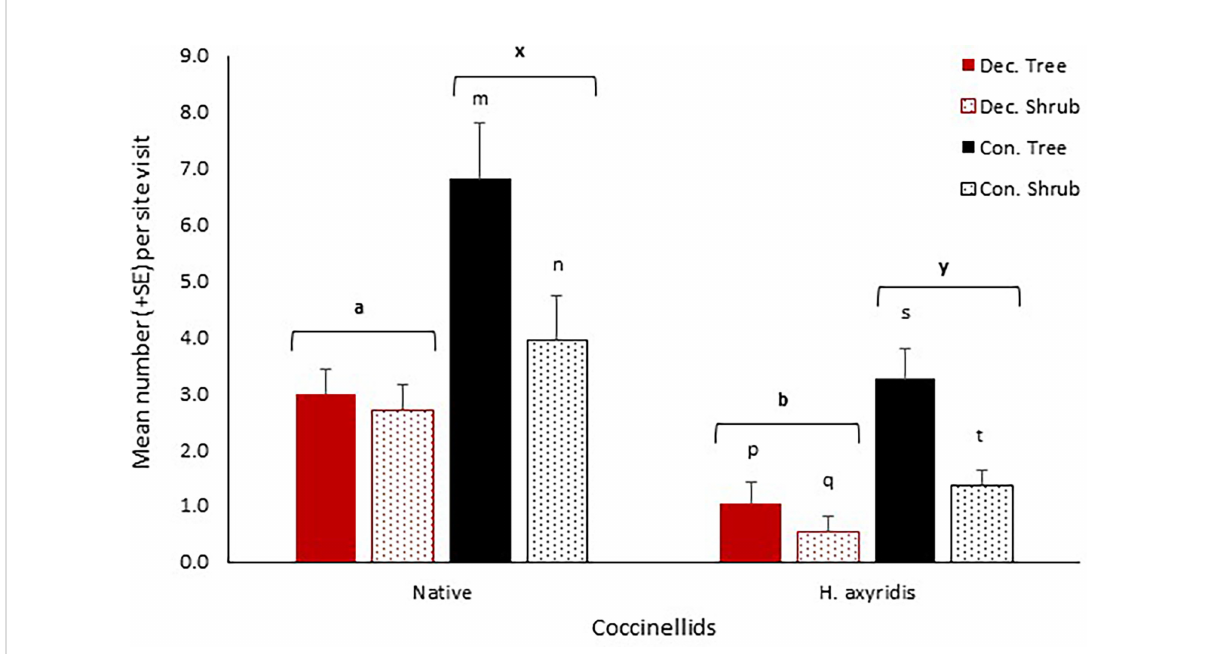
FIGURE 1 Mean number (+SE) per site visit of coccinellids recorded in woodland at deciduous-only and coniferous-only sites in Cambridgeshire and Suffolk. Native = all native coccinellids recorded; Dec. = Deciduous; Con. = Coniferous; Tree = Tree layer; Shrub = Shrub layer. Square brackets indicate the grouping of the Tree and Shrub layer for the respective deciduous and coniferous sites. Consecutive letters indicate where signi fi cant differences occur.